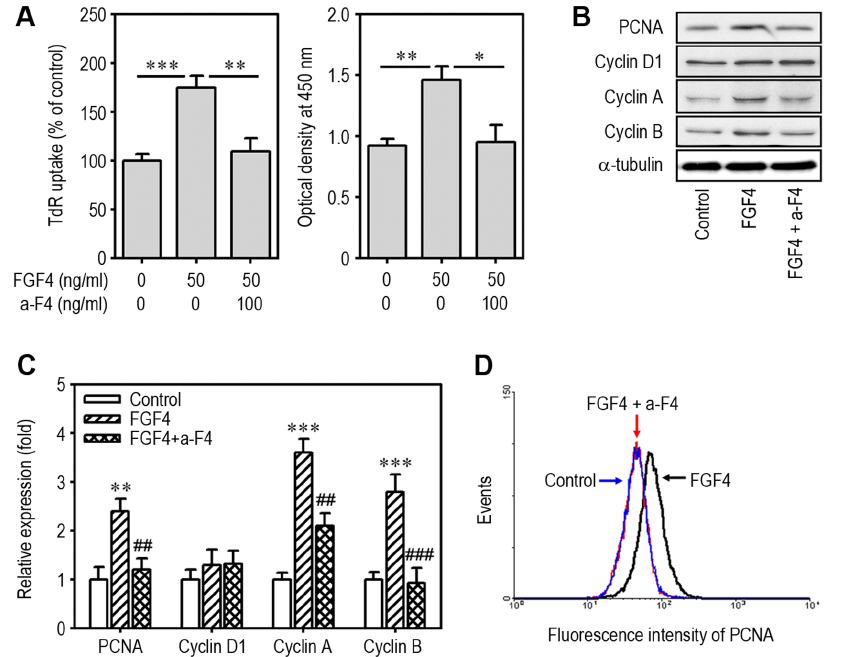
Figure 2. Effects of anti-FGF4 antibody on FGF4-induced cell proliferation and protein expression associated with cell cycle progression. mESCs cultured in 6-well culture plates were incubated in the presence of 50 ng/ml FGF4 and/or 100 ng/ml anti-FGF4 antibody and then proliferation rates were analyzed using 3 H-TdR incorporation (A, left panel) and Cell Counting Kit-8 (A, right panel) 48 h after treatment. *p , 0.05, **p , 0.01, and ***p , 0.001 indicate significant differences between experiments. (B) Expression patterns of cell cycle regulatory proteins 24 h after treatment were analyzed by Western blotting. (C) Data from Western blot analysis were quantified by densitometry after normalizing bands to a -tubulin levels. **p , 0.01 and ***p , 0.001 vs. untreated cells. ## p , 0.01 and ### p , 0.001 vs. cells treated with FGF4 only. (D) mESCs cultured under the same conditions as (C) were also processed for analysis of PCNA expression by flow cytometry. a-F4, anti-FGF4 antibody. FGF4 enhanced cellular levels of PCNA, cyclin A, and cyclin B proteins, whereas the addition of anti-FGF4 antibody reduced them to basal levels (Figs. 2B and C). In addition, FGF4-mediated increase in fluorescence intensity specific for PCNA was reduced to level similar to that of non-treated cells (Fig. 2D).